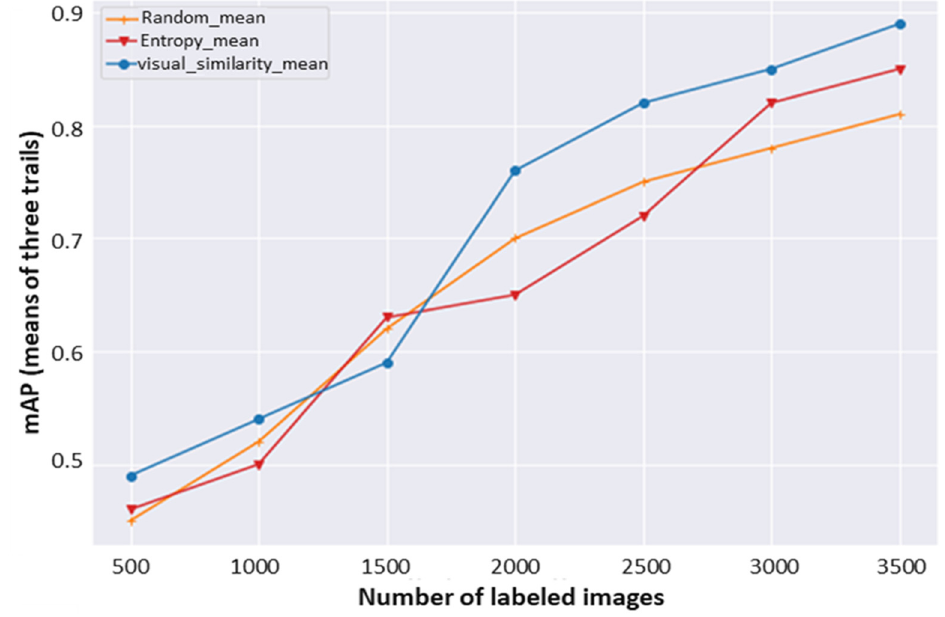
Figure 15. Active learning results of the object detection via the proposed VPP framework used to automatically annotate the VP objects in the VP images in our MOMRAH